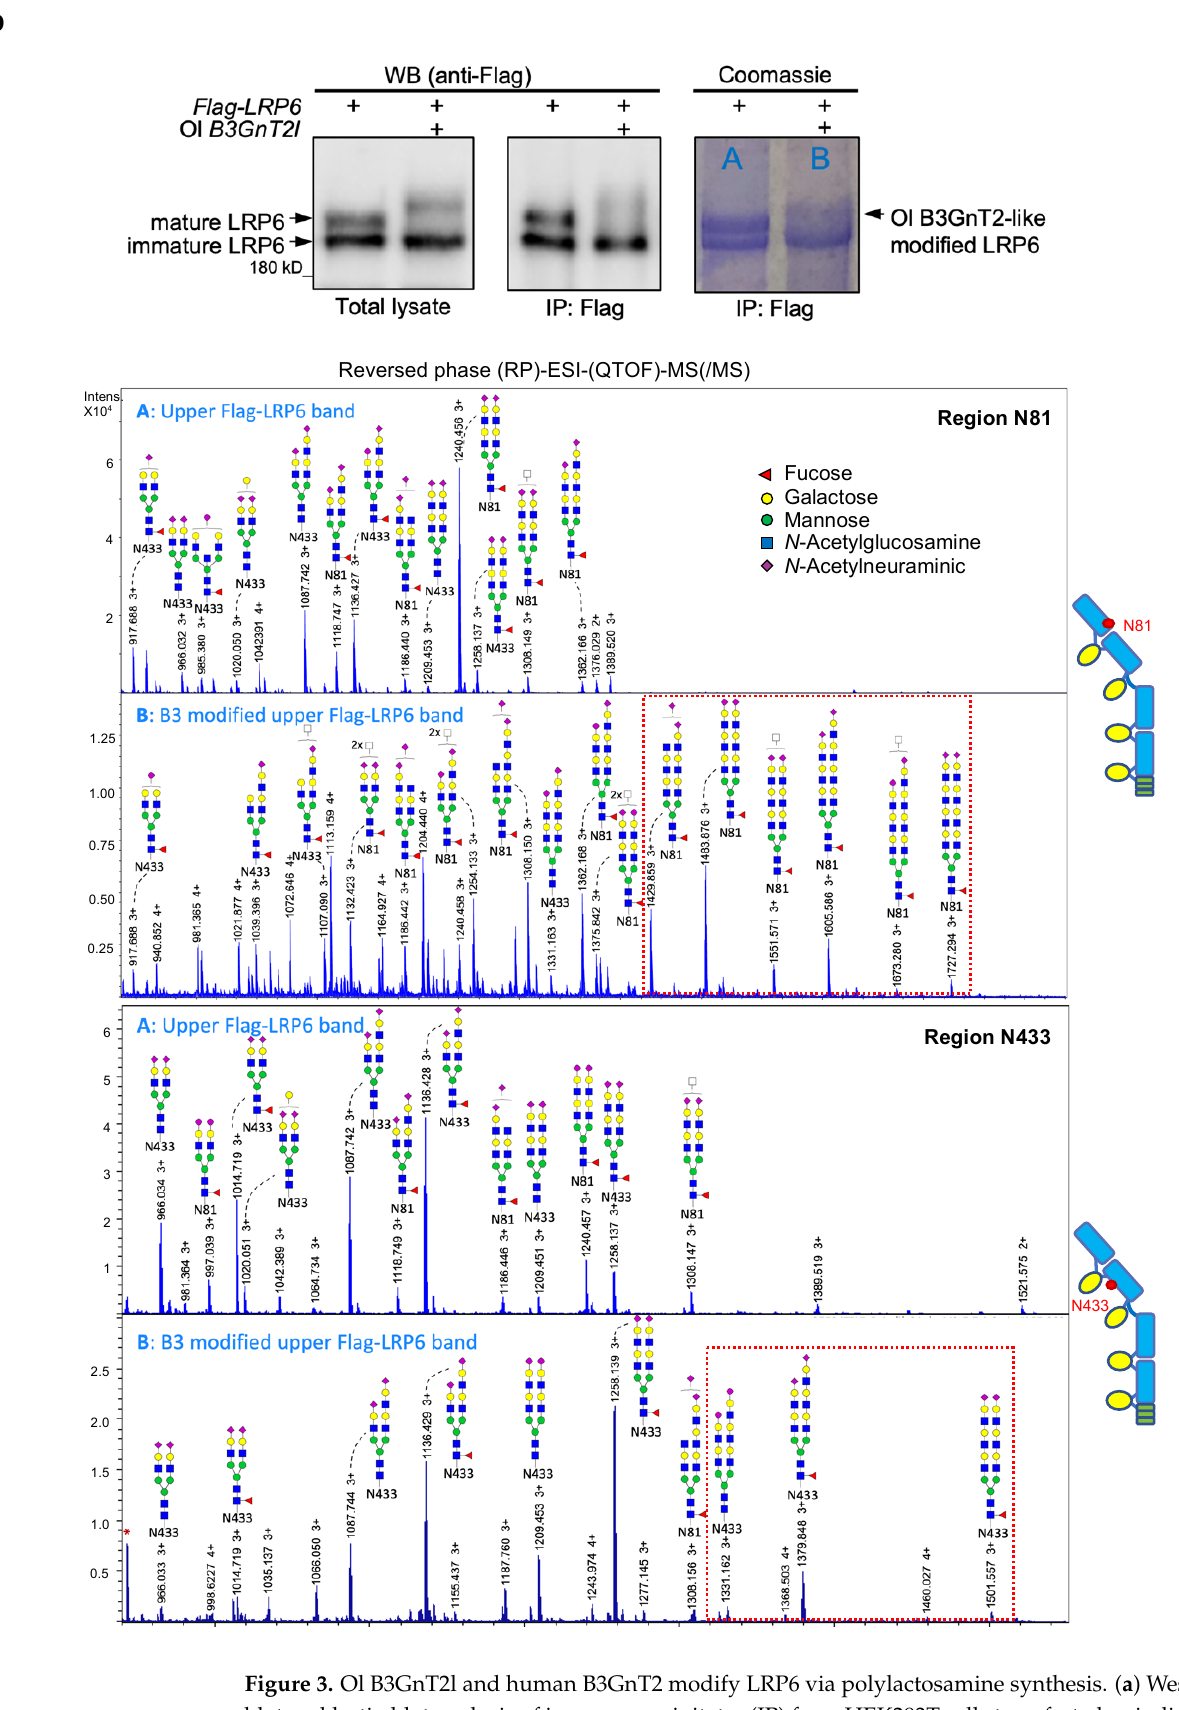
Figure 3. Ol B3GnT2l and human B3GnT2 modify LRP6 via polylactosamine synthesis. ( a ) Western blot and lectin blot analysis of immunoprecipitates (IP) from HEK293T cells transfected as